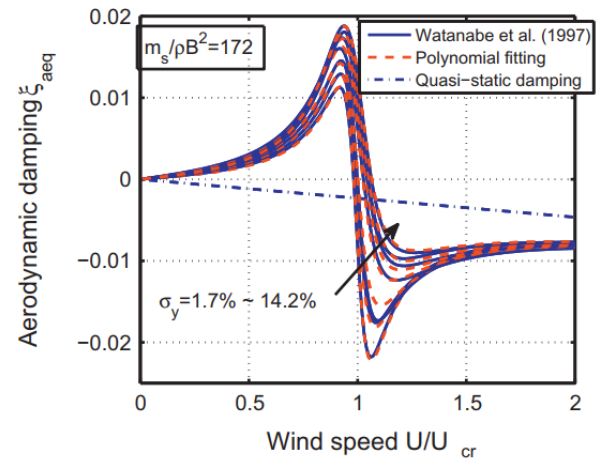
Figure 14. Aerodynamic damping of a test model evaluated by nonlinear mathematical models and the classic quasi-steady theory